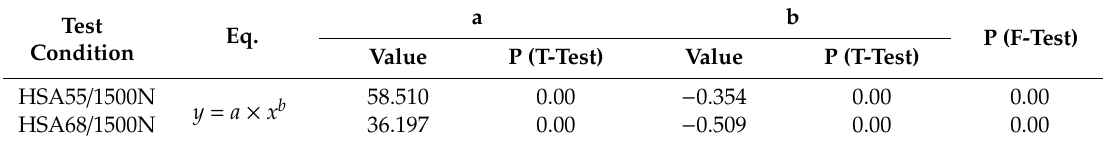
Figure 9. ( a ) Relationship between the contact area and the value of Sq under different rubber hardnesses; ( b ) Normal probability graphs of the residual of the corresponding fitting curves. Table 3. Parameters of the fitting curves for different rubber hardness